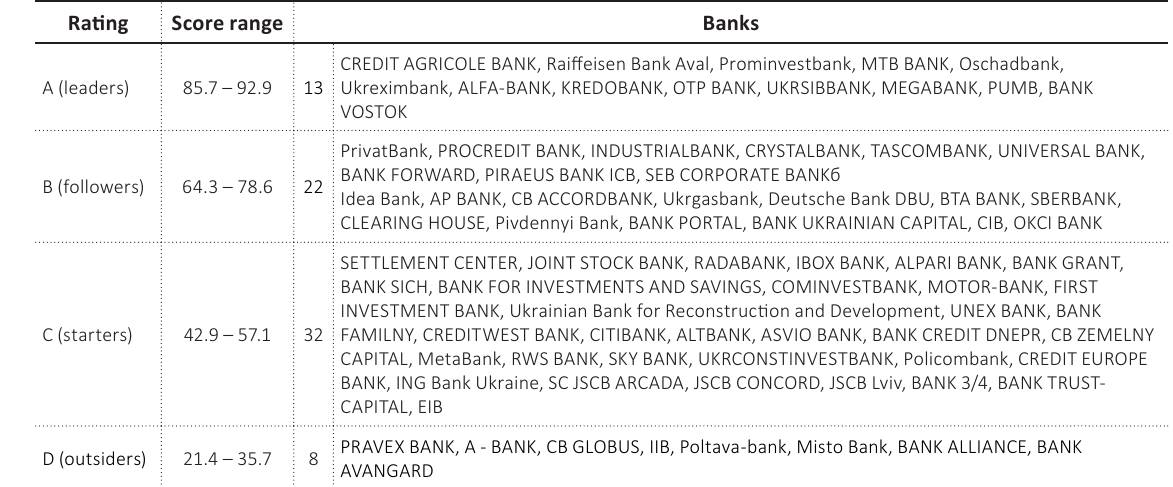
Table 3. Grouping of Ukrainian banks by the value of the Q&C BMR